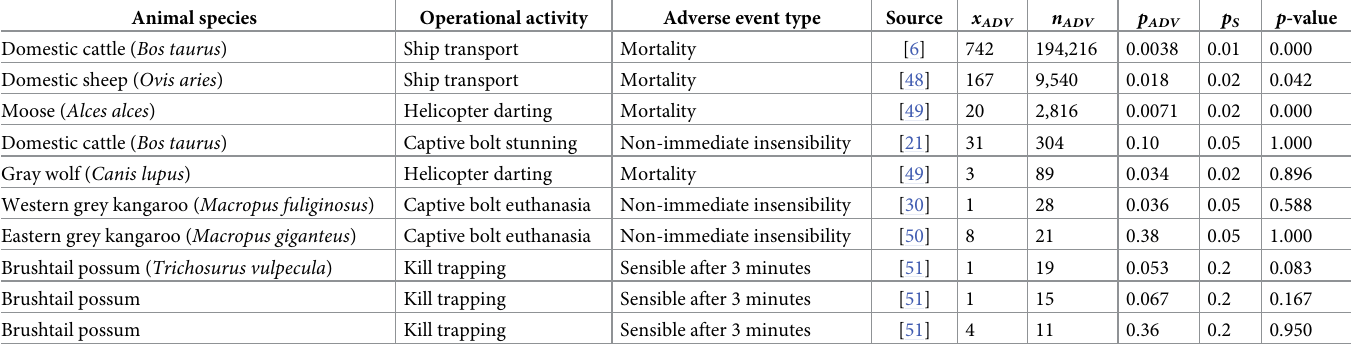
Table 3. The frequency of given adverse events ( p ADV ) as assessed in 10 published studies of operational animal use activities, and the p -values from an exact hypothesis–testing procedure using the alternative hypothesis H A : p ADV < p S .